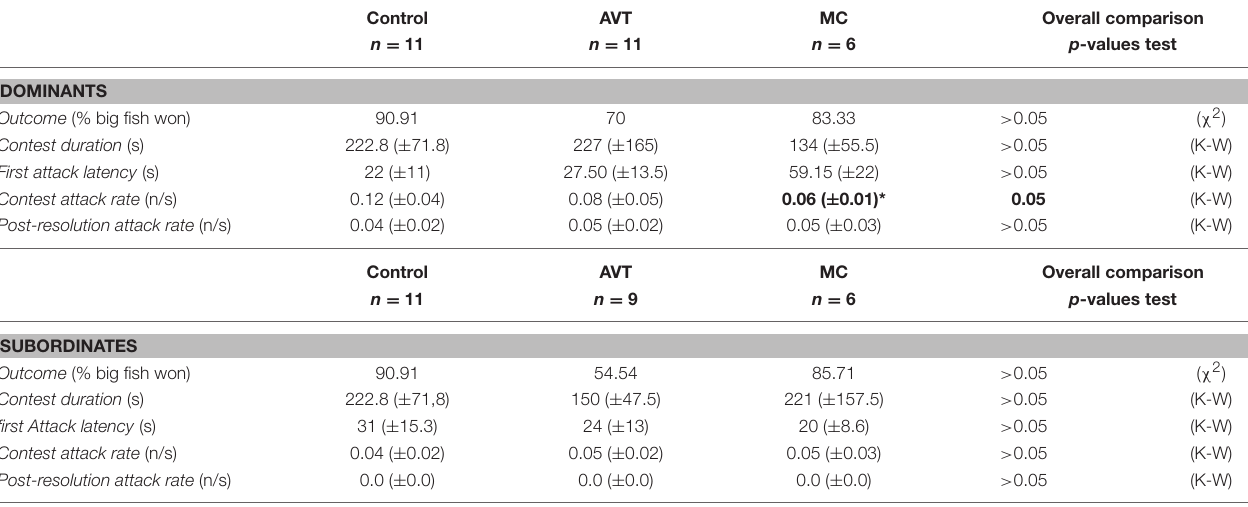
TABLE 1 | Locomotor parameters of agonistic encounters under different treatments.